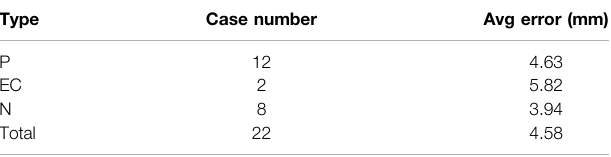
TABLE 3 | Average errors of ET in cases with ET > 3 mm and errors > 2 mm Type